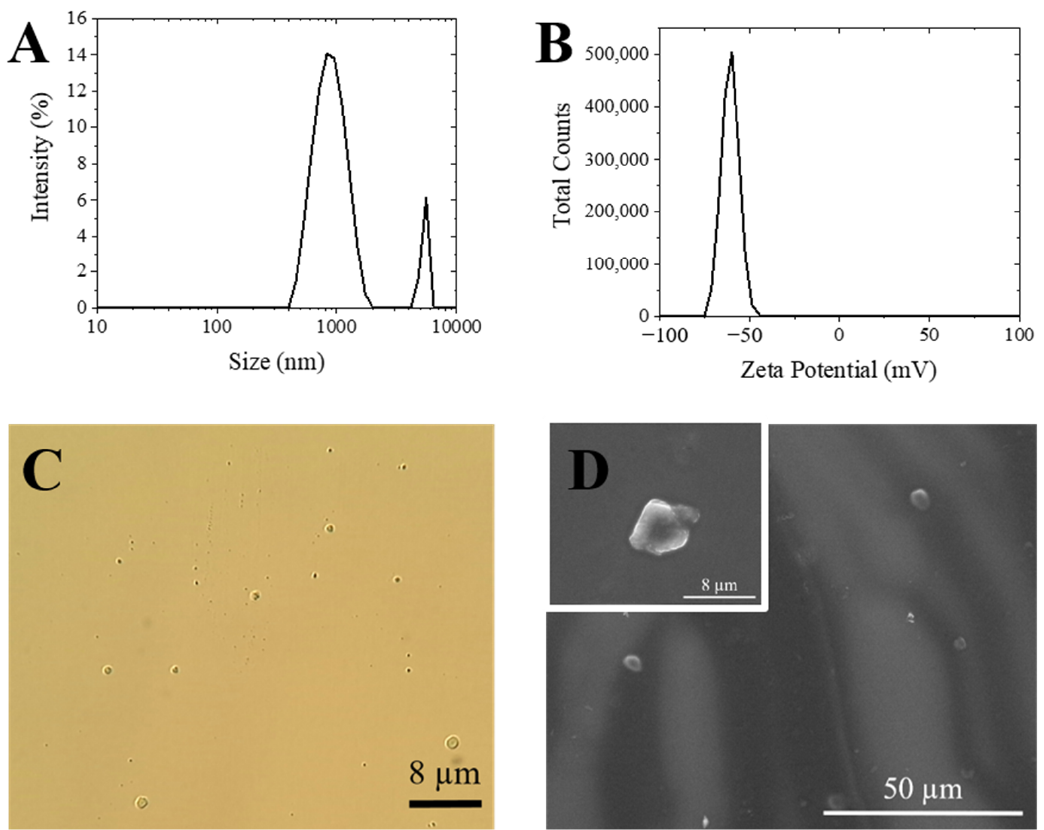
Figure 7. Characterization of Alg-Ppz MPs. ( A ) Size distribution by DLS; ( B ) zeta potential by DLS; ( C ) optical microscope image; ( D ) ESEM images.